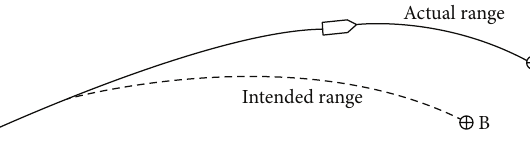
Figure 7: The intended and actual paths of the